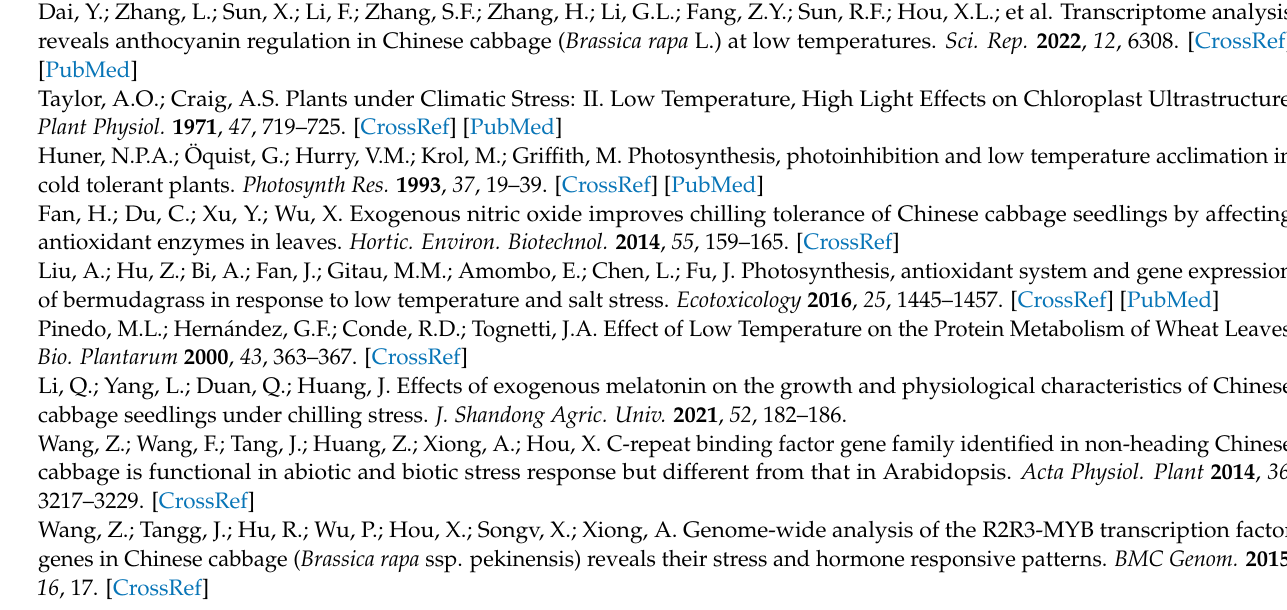
Table S2: Statistics of Illumina sequencing data. Table S3: List of 8845 genes table for WGCNA. Table S4. List of genes related to lignin synthesis pathway. Table S5. Promoter cis-acting elements analysis of the 29 BrCOMT